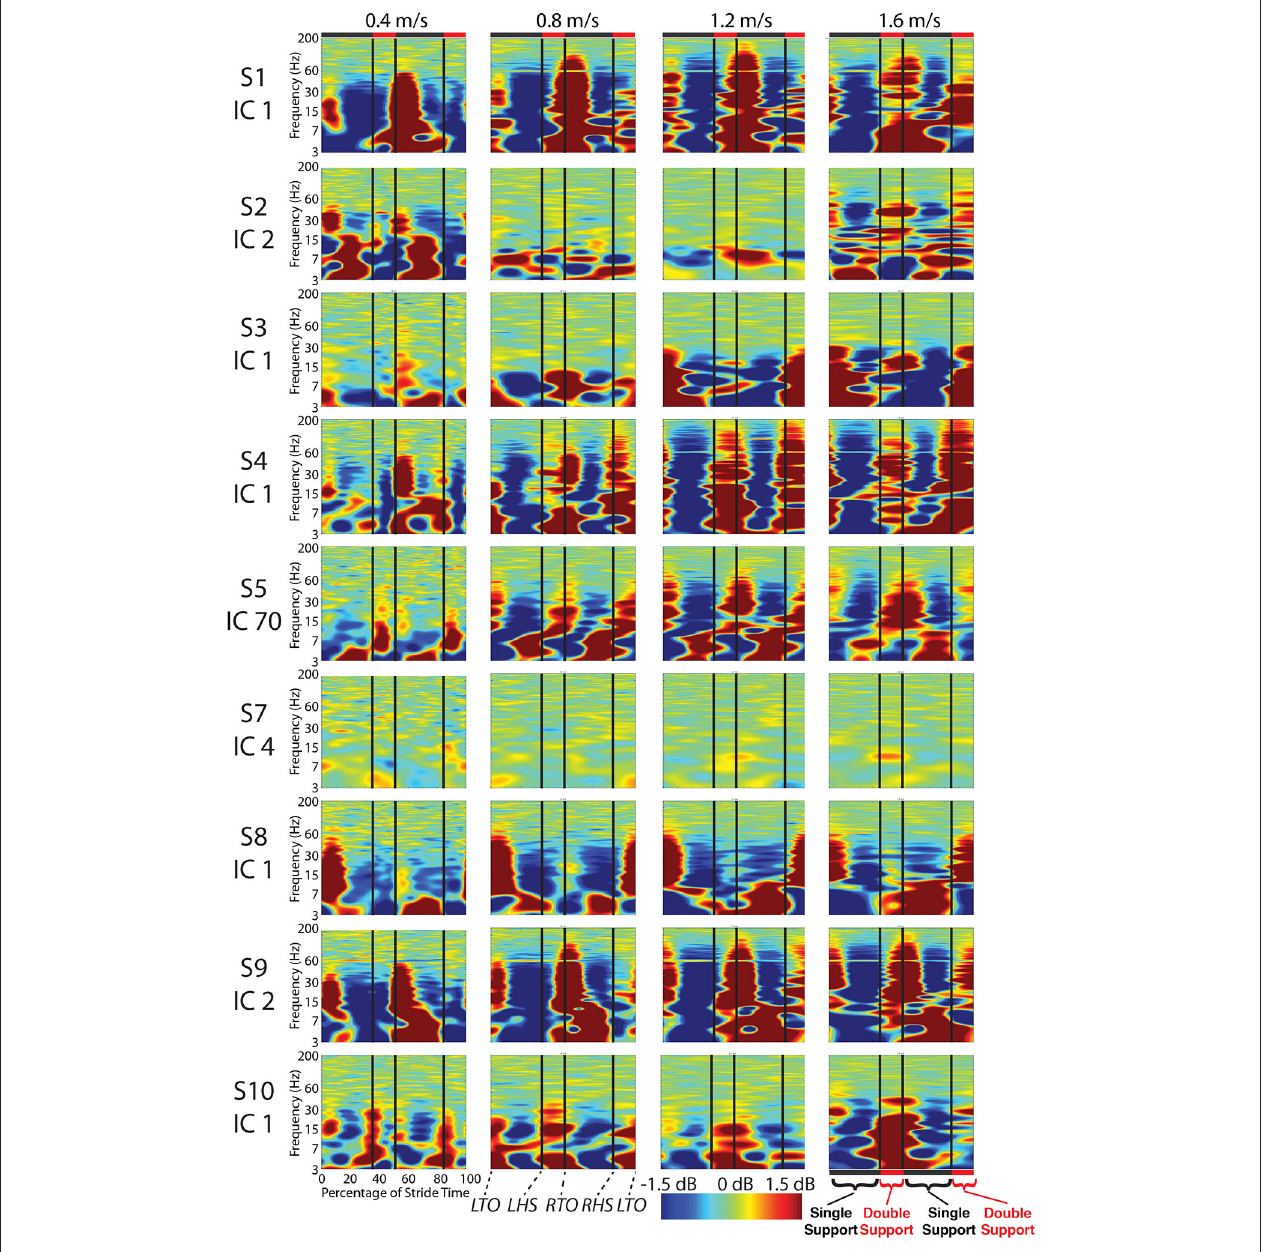
FIGURE 5 | Cortical component event related spectral perturbations. Event related spectral perturbations for the nine components with RVs < 15% and locations in the cortex show signs of movement artifact such as large broadband spectral fluctuations. Vertical lines indicate median gait event times for all subjects for all speeds for: left toe-off, left heel strike, right toe-off, and right heel